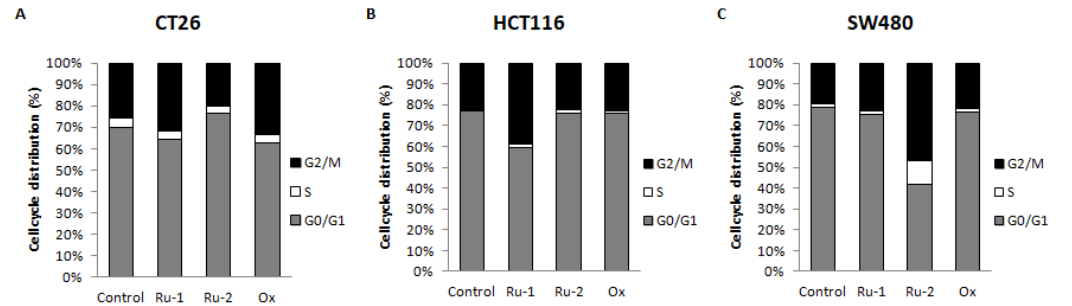
Figure 7. Effects of ruthenium(II) terpyridine complexes on cell cycle distribution. ( A ) CT26 cells; ( B ) HCT116 cells; ( C ) SW480 cells. Cell cycle of colon cancer cells was analyzed by flow cytometry. Results are expressed as the percentage of cells in different phases of the cell cycle. Data are presented as the mean ± SD of three independent experiments.